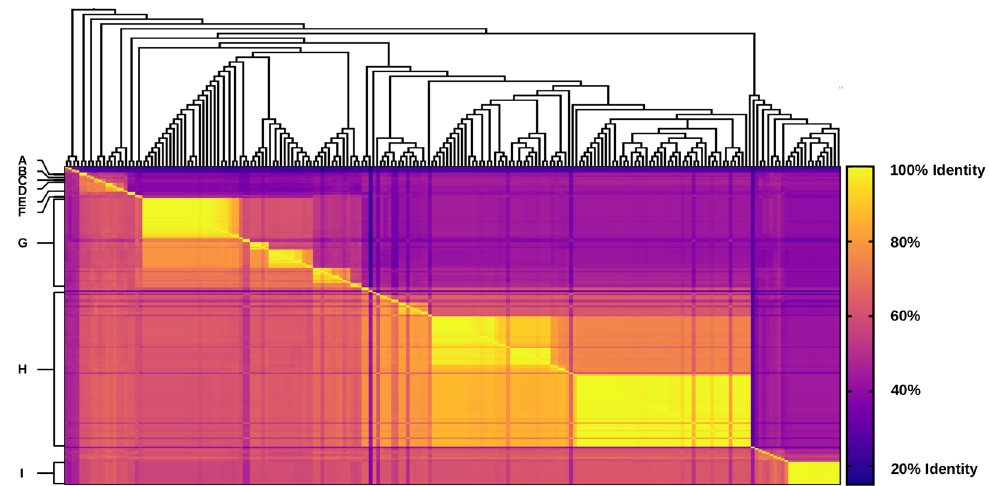
Figure 2. Heat map with identities and similarities of integron integrases from Shewanella spp. based on their amino acid sequences. Letters in y-axis and cladogram correspond to the phylogenetic tree and integrase classification from Figure 3. The colored scale depicts the percentages of similarity and